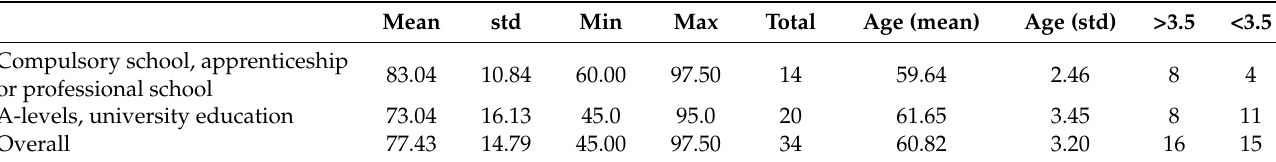
Figure 6. Results for system usability scale after using the robot ( n = 34). Table 6. Summary of the SUS scale based on the educational level ( n = 34).